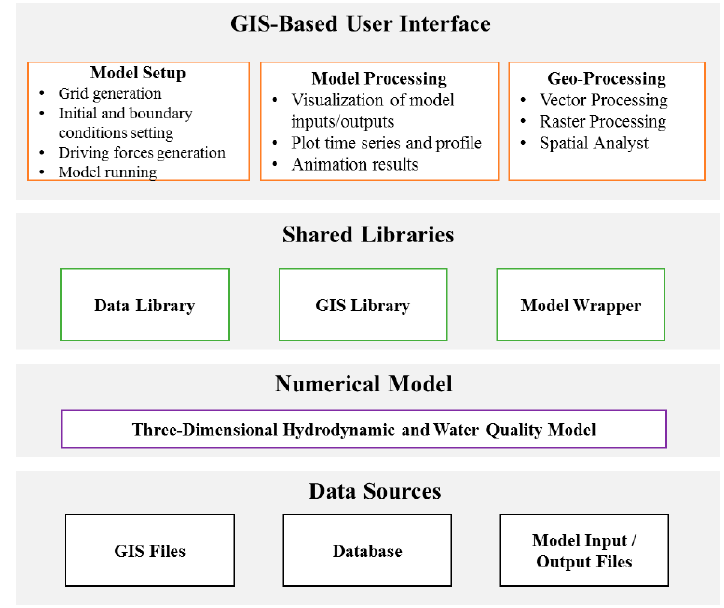
Figure 2. Conceptual diagram of integration of a GIS and a three-dimensional hydrodynamic and water quality model.